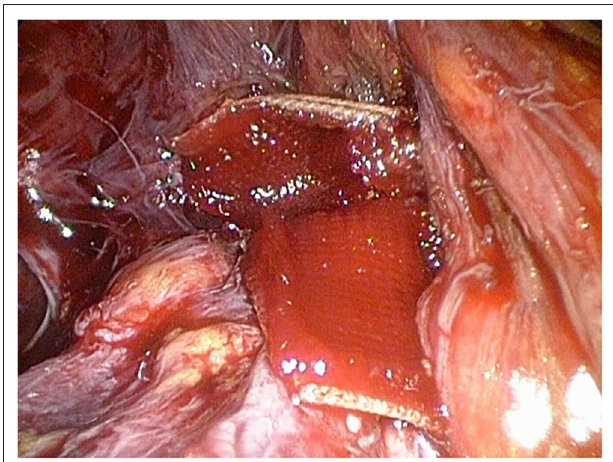
FIGURE 3 | The defect is sutured (not shown) and additionally covered by a hemostatic patch (Veriset, Covidien).